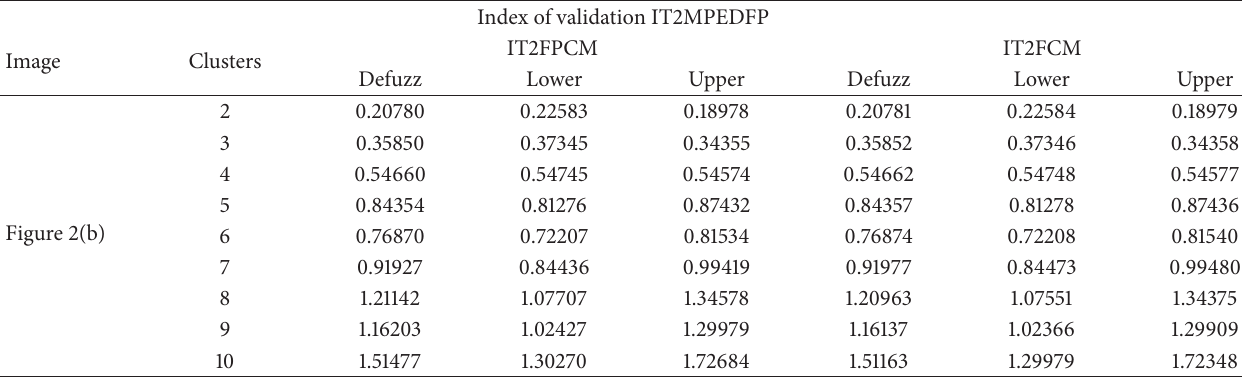
Table 29: Results of the IT2MPE-DMFP validation index to data clustering of image shown in Figure 2(b) using IT2FPCM and IT2FCM algorithm with 𝑚 = [1.5, 2.5] and 𝜂 = [1.5, 2.5] as parameters.